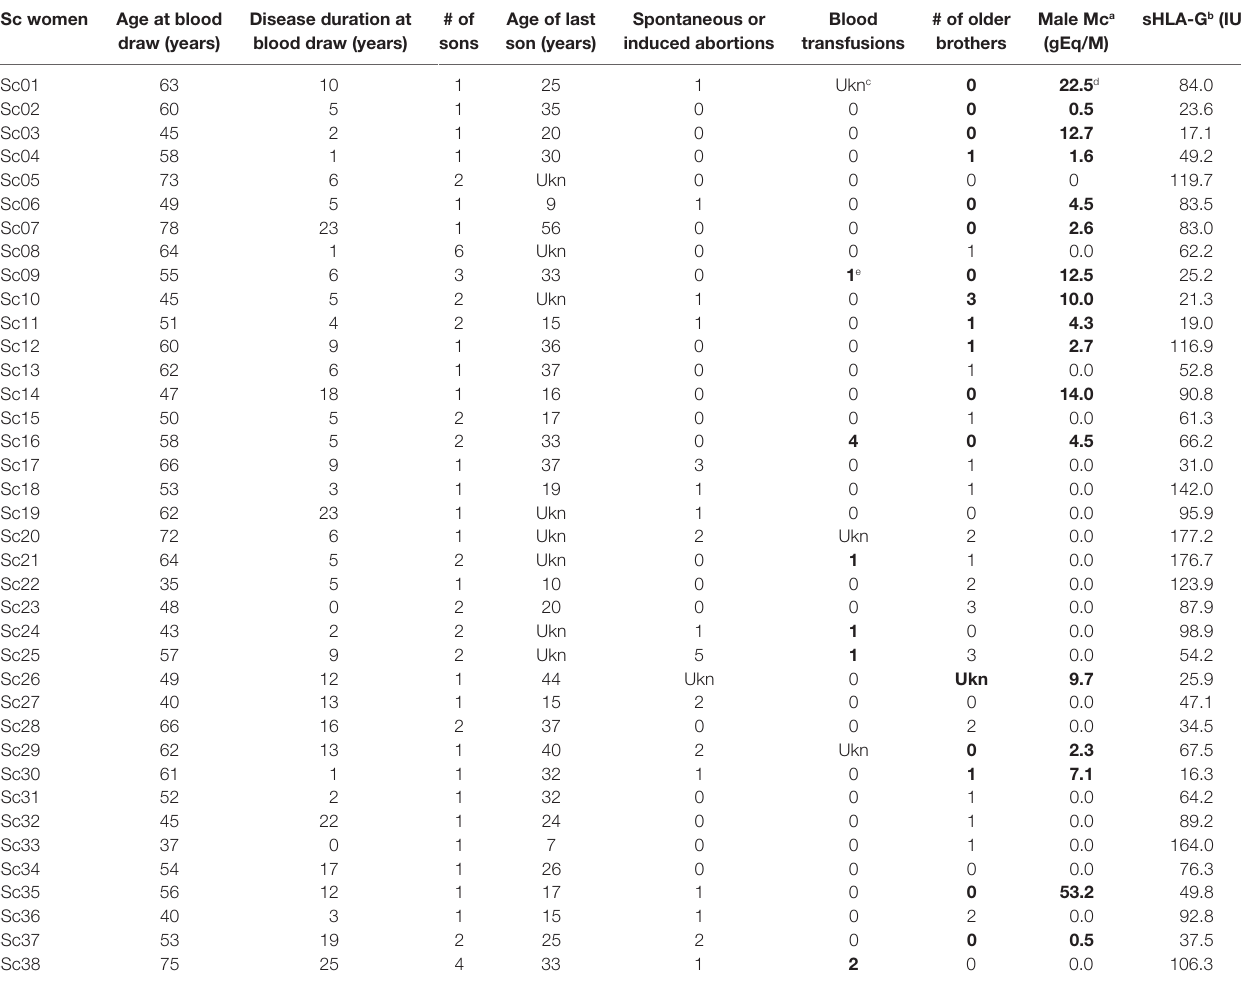
TaBle 1 | Obstetrical and clinical characteristics of women with SSc quantified for male DNA and soluble HLA-G (sHLA-G) levels. ssc